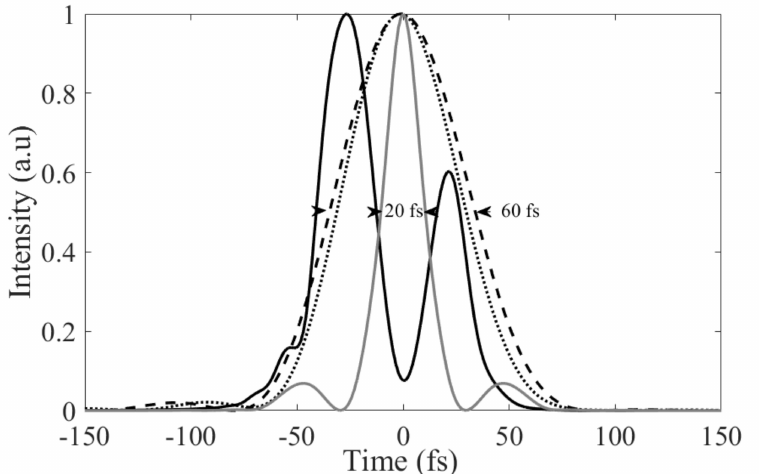
Figure 7. Temporal profiles of the MIR band (black solid-line) and filtered spectra at 3.4 or 4.2 µ m (black dashed or dotted line). The grey solid-line corresponds to the pulse profile without the filter when the total phase is